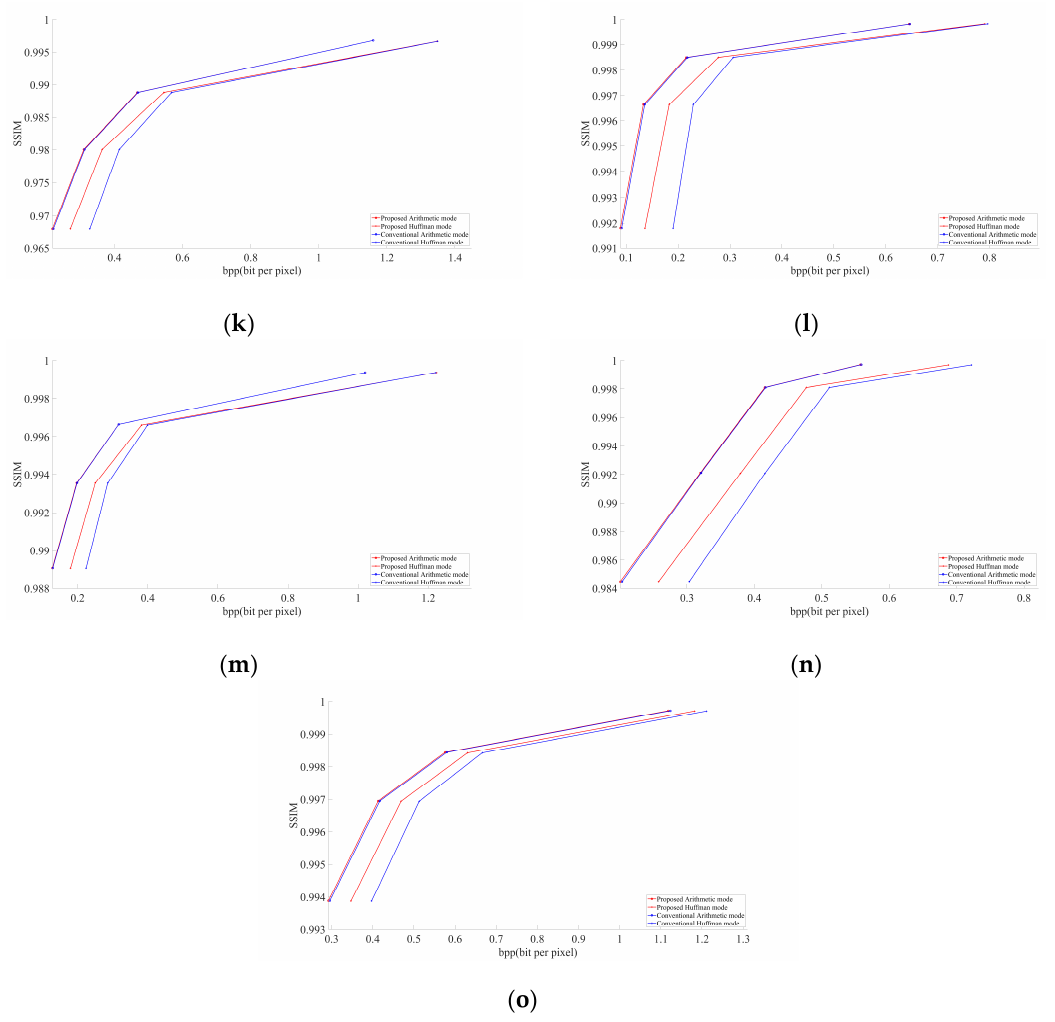
Figure 6. SSIM results of test images shown in Figure 4: ( a ) Street View, ( b ) Woman, ( c ) Night Scene ( d ) Jars, ( e ) Flowers, ( f ) Glasses, ( g ) Screenshot1, ( h ) Screenshot2, ( i ) Spoon, ( j ) Sunset, ( k ) Paris, ( l ) Ice Cream, ( m ) Air Jet, ( n ) Statue, ( o ) Icon.